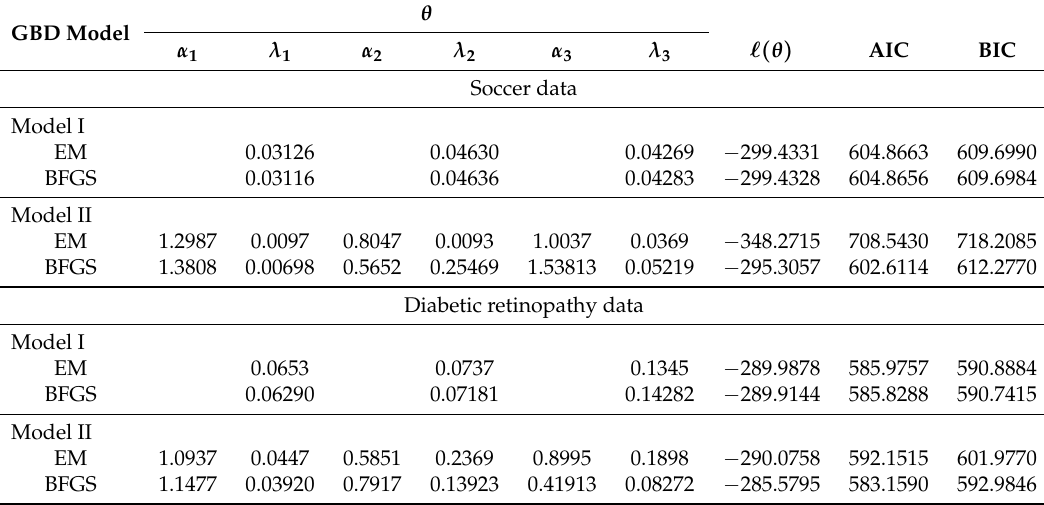
Table A1. Summary of fitted GBD models for the two real data. EM rows are the parameters estimated with the EM algorithm for maximizing the pseudo log-likelihood function, along with the log-likelihood, AIC and BIC values, and BFGS rows correspond to the results obtained by applying the Broyden–Fletcher–Goldfarb–Shanno algorithm for maximizing the log-likelihood function. θ GBD Model α